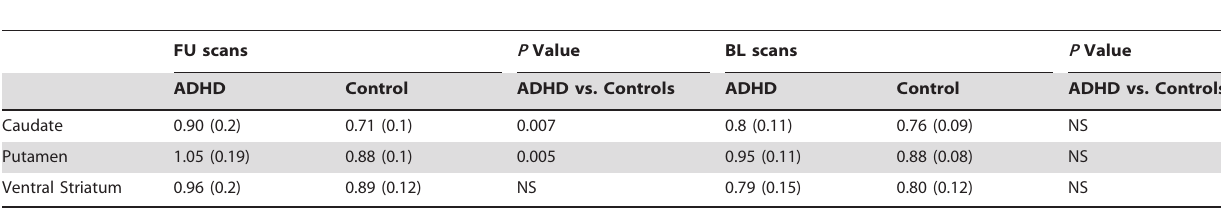
Table 4. Measures [mean (SD)] of dopamine transporter availability (BP ND ) of control subjects at baseline (BL) and 12 months follow-up (FU) and ADHD subjects prior to (BL) and after 12 months oral methylphenidate treatment